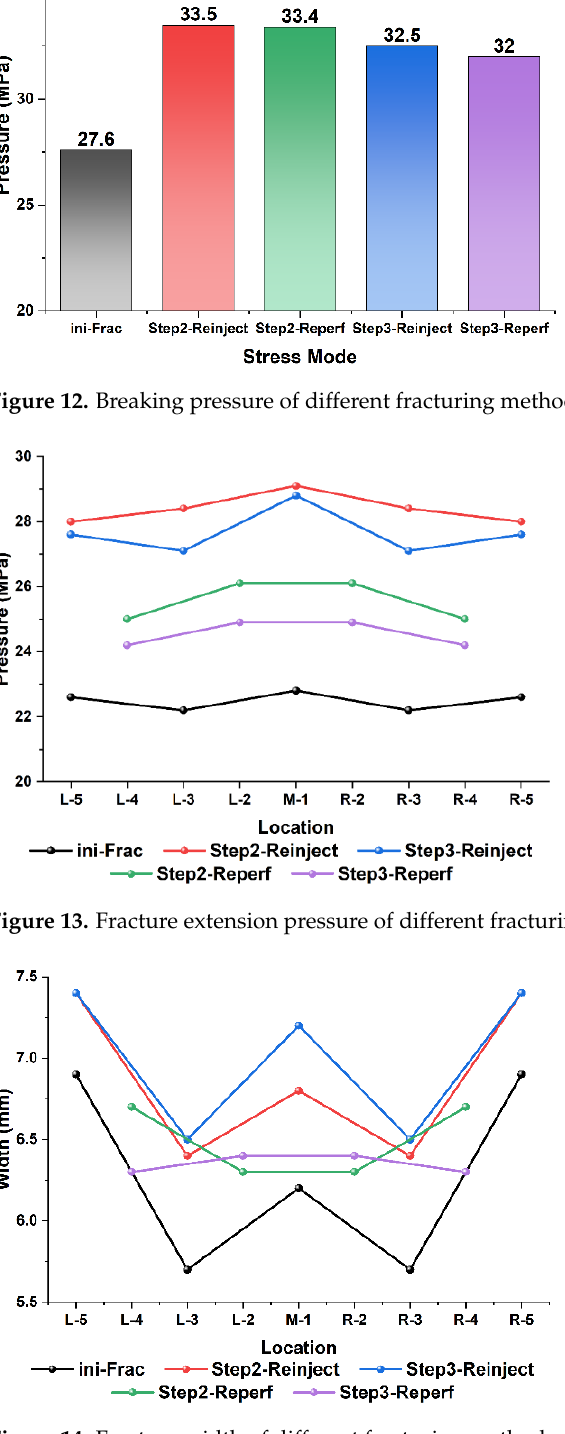
Figure 15. Fracture lengths of different fracturing methods. 4. Discussion 4.1. Fracturing Fluid Filtration Loss and Variation of Pore Pressure The pore pressure curve in Figure 8 shows that as the fracture expands, the pore pressure at the injection point gradually increases, indicating that the fracture extension pressure gradually increases. The fluid in the fractures is lost to the surrounding for- mations after fracturing. Figure 16 depicts the seepage field after the pump has been turned off for 100 min, while Figure 17 depicts the pore pressure distribution along the process at the end of Steps 2 and 3. Figure 16. The seepage field after the pump was stopped for 100 min. The fracturing fluid continues to filter out into the formation because the fluid pressure in the fracture is still greater than the pore pressure in the reservoir.